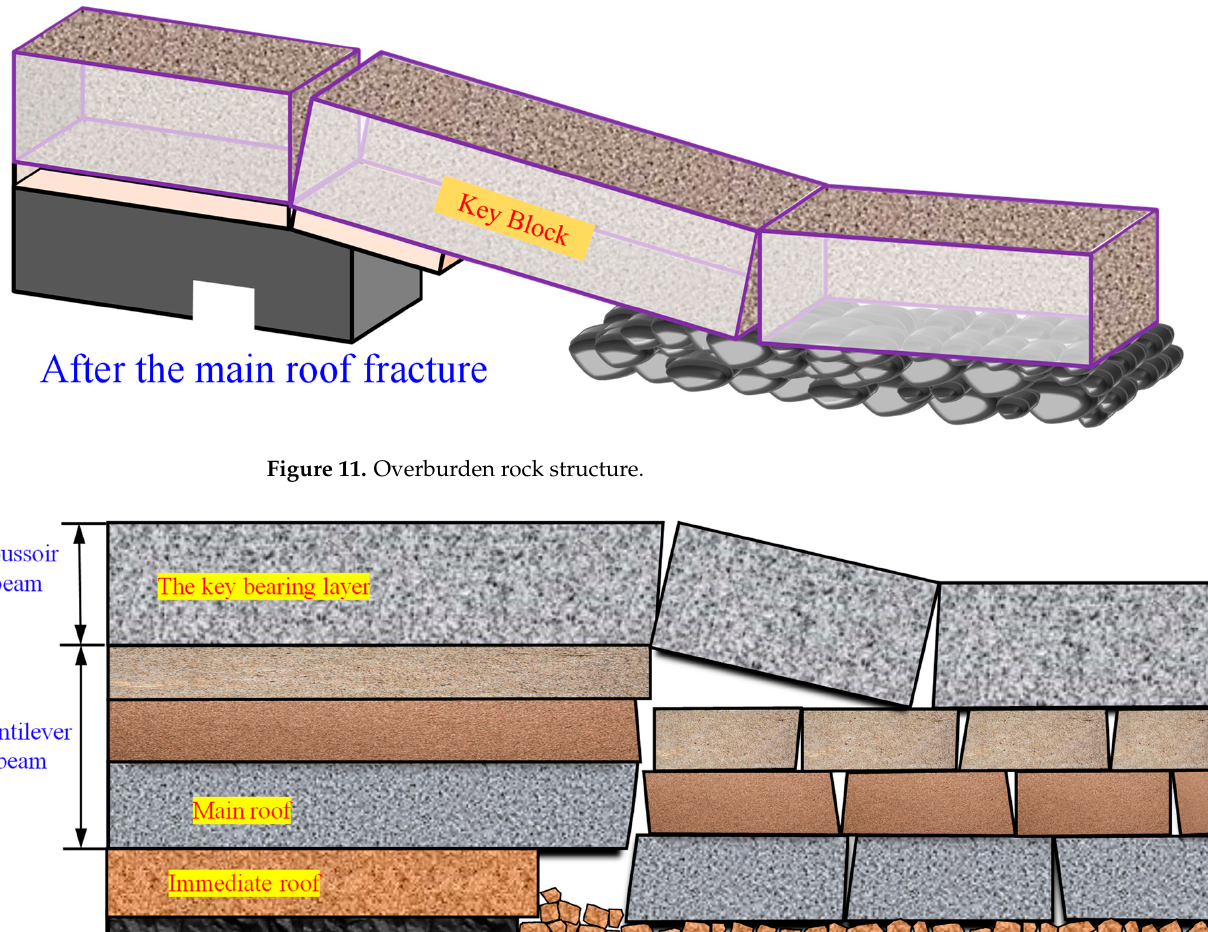
Figure 12. Low-level combined cantilever beam + high-level multilayer masonry beam structure model [50].